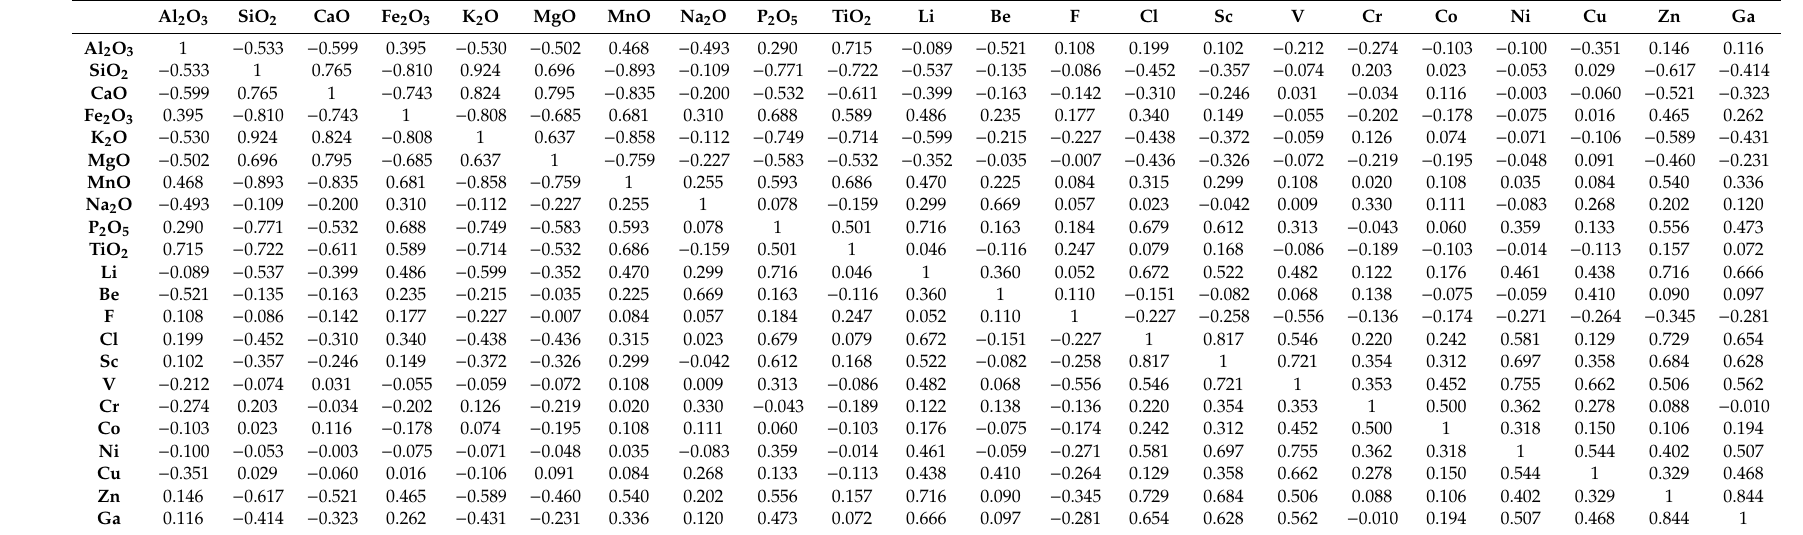
Table 8. Correlation using the ilr on coal and ash basis (Adaohai